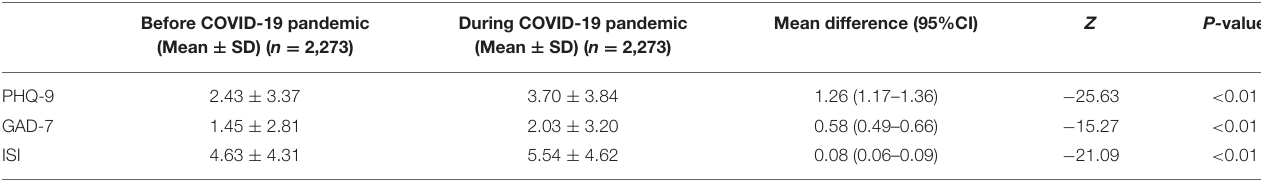
TABLE 3 | Differences of the total score of PHQ-9, GAD-7 and ISI during the COVID-19 pandemic and before the outbreak.